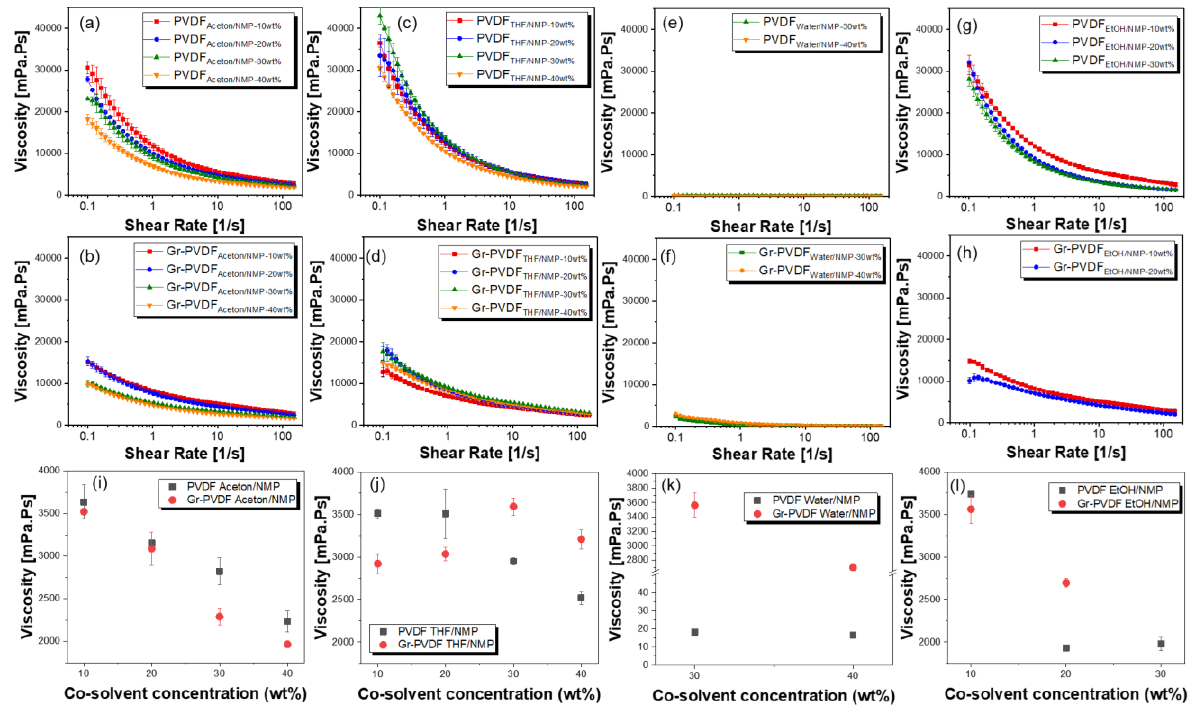
Figure 3. Viscosity changes upon the shear rate of ( a ) PVDF Acetone/NMP , ( b ) Gr-PVDF Acetone/NMP , ( c ) PVDF THF/NMP , ( d ) Gr-PVDF THF/NMP , ( e ) PVDF water/NMP , ( f ) Gr-PVDF water/NMP , ( g ) PVDF EtOH/NMP , ( h ) Gr- PVDF EtOH/NMP solutions with different co-polymer concentrations. ( i – l ) Apparent viscosity at a shear rate of 60 s⁻ 1 .